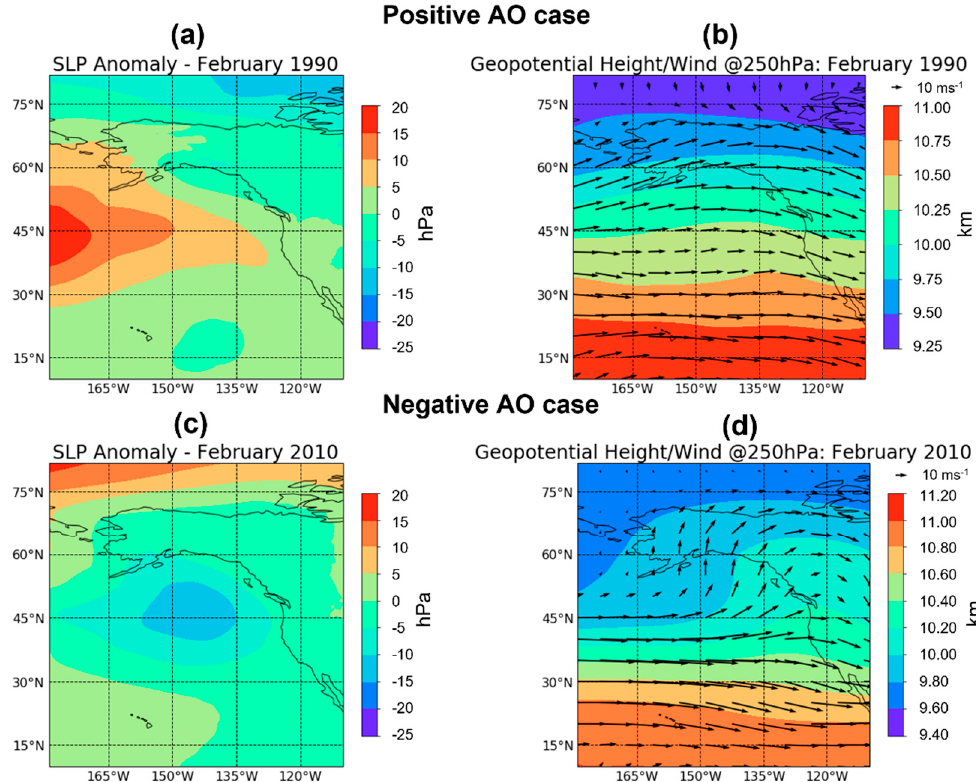
Figure 4. Longitude-latitude cross-section of ( a , c ) sea level pressure (SLP) anomaly and ( b , d ) 250 hPa geopotential height and horizontal wind for top positive (>+1.5) and top negative (< − 1.5) AO months. The anomaly is computed by subtracting the climatological February mean (1980–2019) from the given negative and positive AO February monthly mean value.